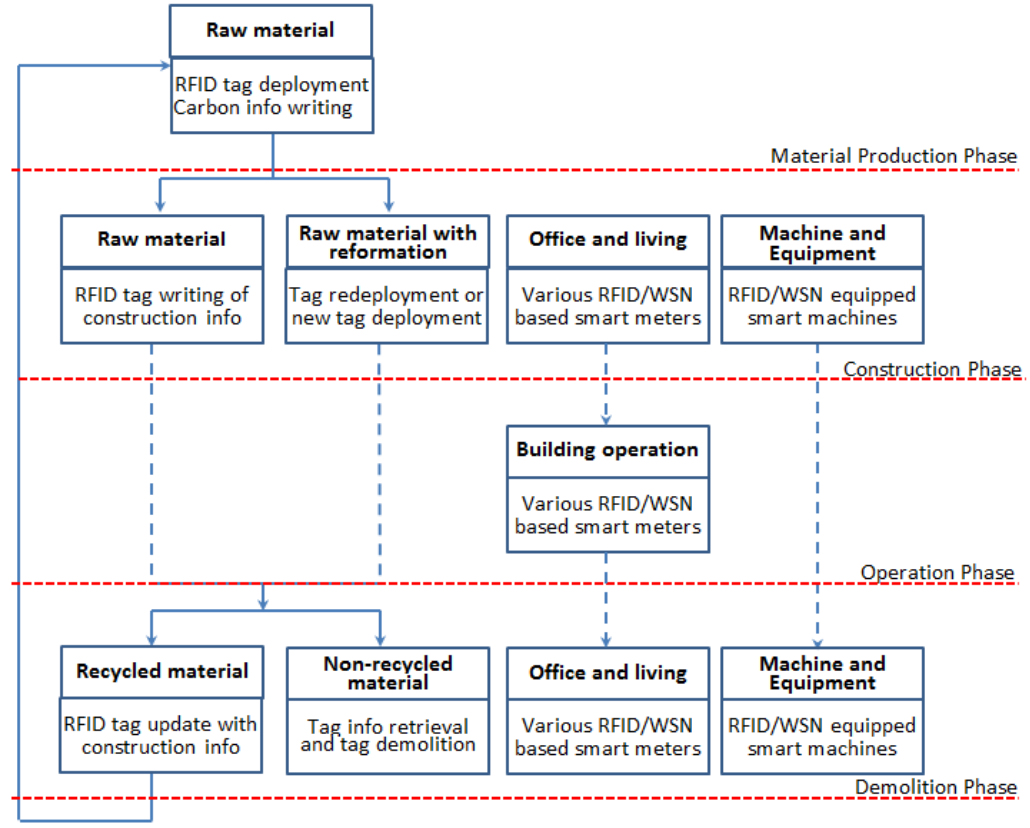
Figure 3. The connection between the design concept and Figure